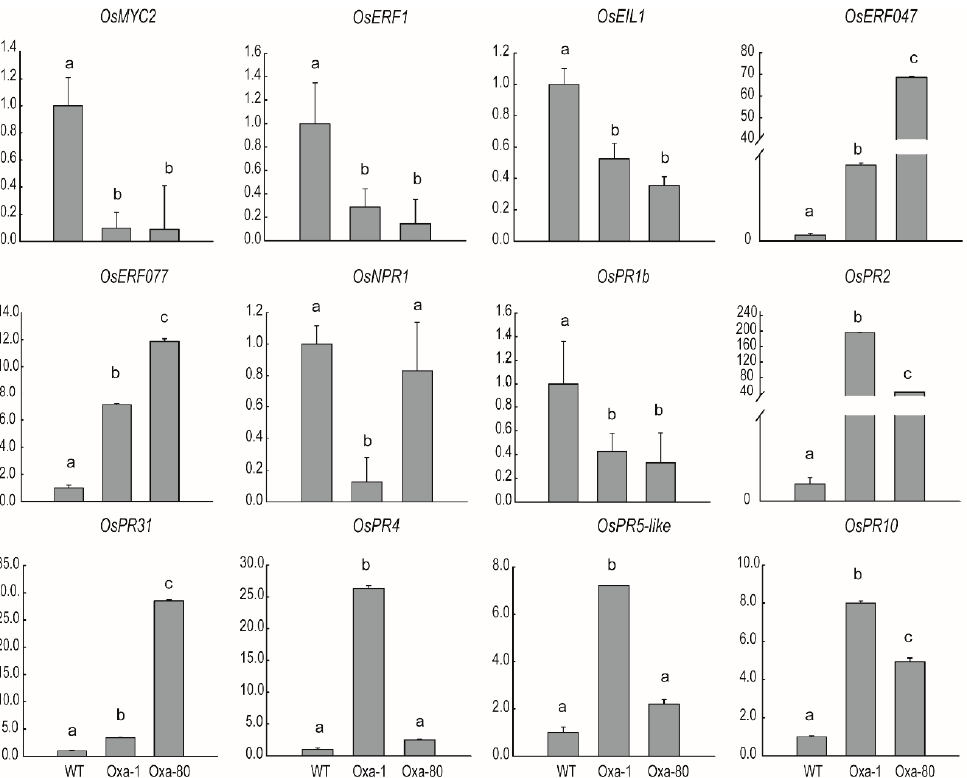
Figure 9. Expression analysis of necrosis-development-related genes in OsJAZ13a -overexpression lines. RNA was extracted from rice leaves of OsJAZ13a overexpression lines and wild type, and which were planted in greenhouse and lesion appeared on the sheath of transgenic plants. We performed qRT-PCR to analyze associated genes involved in JA / ET signaling pathway OsMYC2 , OsERF1 , OsEIL1 , OsERF047 , and OsERF077 ; pathogen-defense genes OsNPR1 and OsPR1b ; and defense-related genes OsPR2 , OsPR31 , OsPR4, OsPR5-like , and OsPR10 . ACTIN served as the internal control. The values are means ± SD ( n = 3 replicates). Different lowercase letters indicate significant differences ( p < 0.05). The y -axis represents the relative expression level. This experiment was performed for three independent biological repeats.